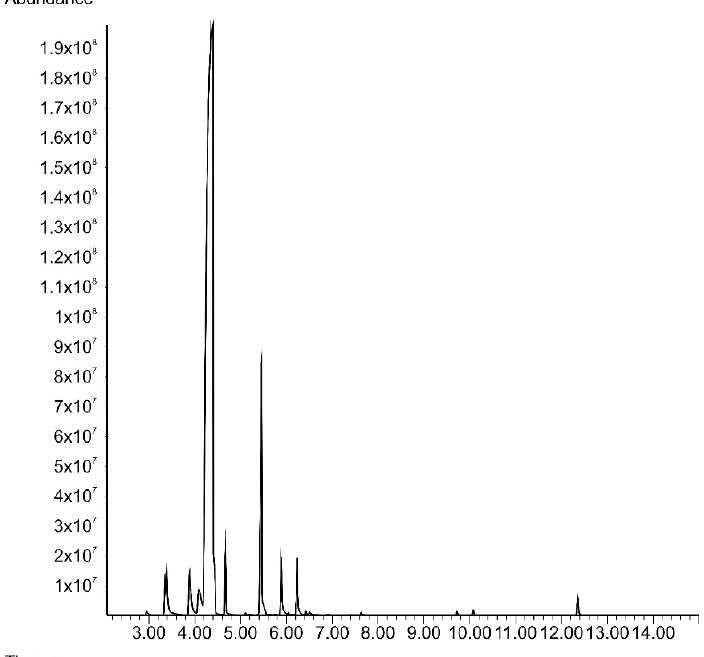
Figure A2. The gas chromatogram of the rosewood commercial oil. Dilution 1:40 (v/v) in dichloromethane.